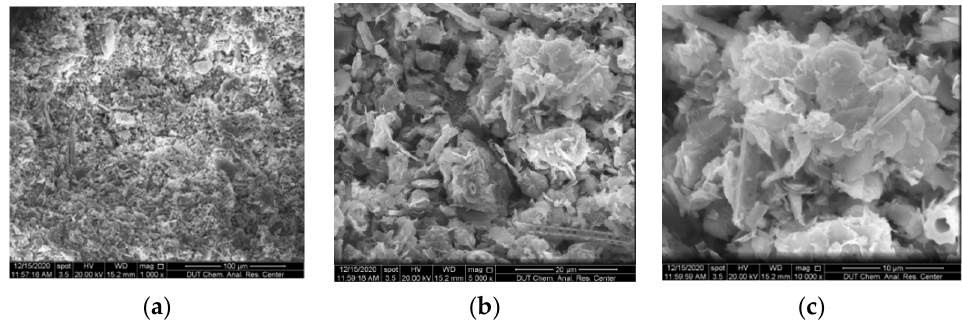
Figure 2. SEM images of the 0–20 cm sediment segment S1 at different magnifications: ( a ) 1000×; ( b ) 5000×; ( c ) 10000×.